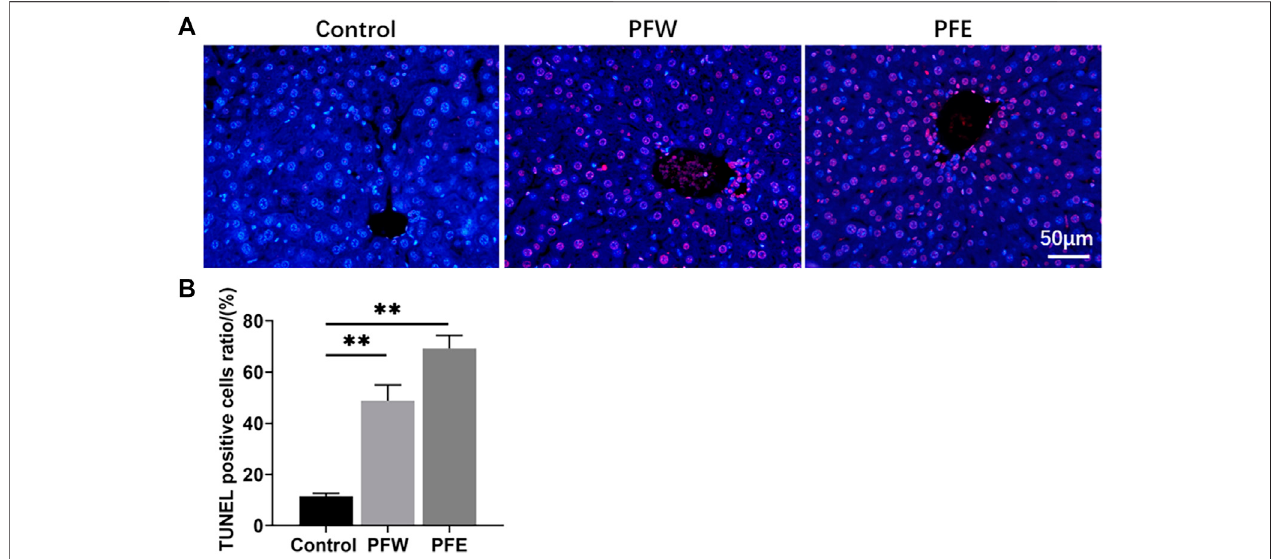
FIGURE2| DetectionofapoptotichepatocytesinhepatictissuesusingTUNELassay. (A) Representativeimagesofeachgroupat × 400magni fi cation. (B) TUNEL- positive cell ratios in each group. Values were presented as mean ± SD and n (cid:1) 4. * p < 0.05, ** p < 0.01 versus the control group.